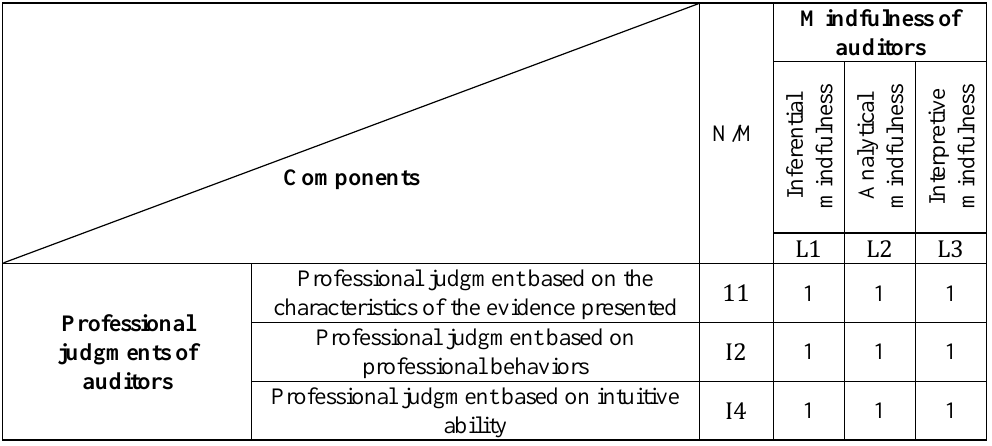
Table 7. the matrix of auditors 'professional judgments of auditors' mindsets